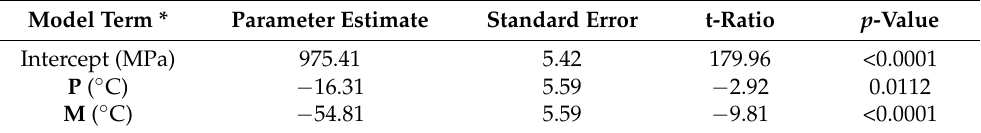
Table 7. Significant terms, estimates, and regression details of Young’s modulus (E) model. Model Term * Parameter Estimate Standard Error t-Ratio p -Value Intercept (MPa)